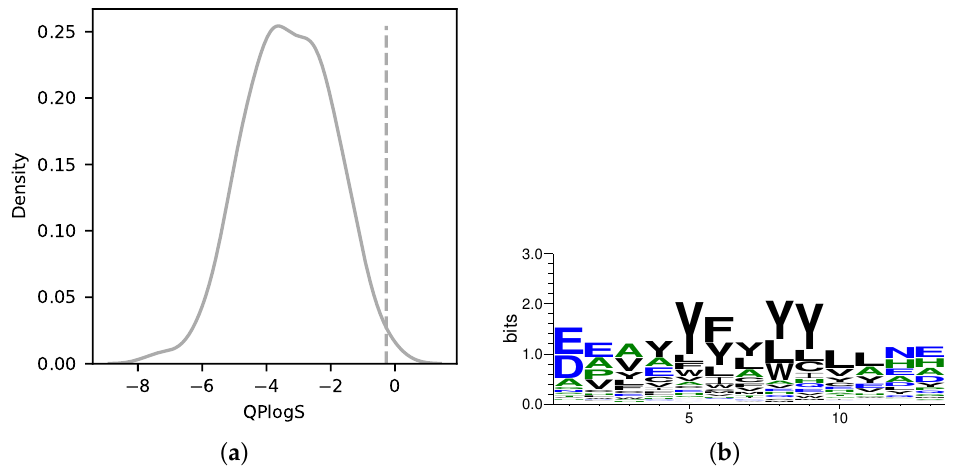
Figure 2. Distribution of logS of MDM2 binder sequences designed by AfDesign and sequence logo of the binder sequences. Distribution of logS calculated by QikProp. Dashed lines are logS values for the p53 peptide ( a ). Sequence logo for sequences designed with the AfDesign binder hallucination protocol ( b ). Hydrophilic amino acids (R, K, D, E, N, and Q) are shown in blue, neutral amino acids (S, G, H, T, A, and P) are shown in green, and hydrophobic amino acids (Y, V, M, C, L, F, I, and W) are shown in